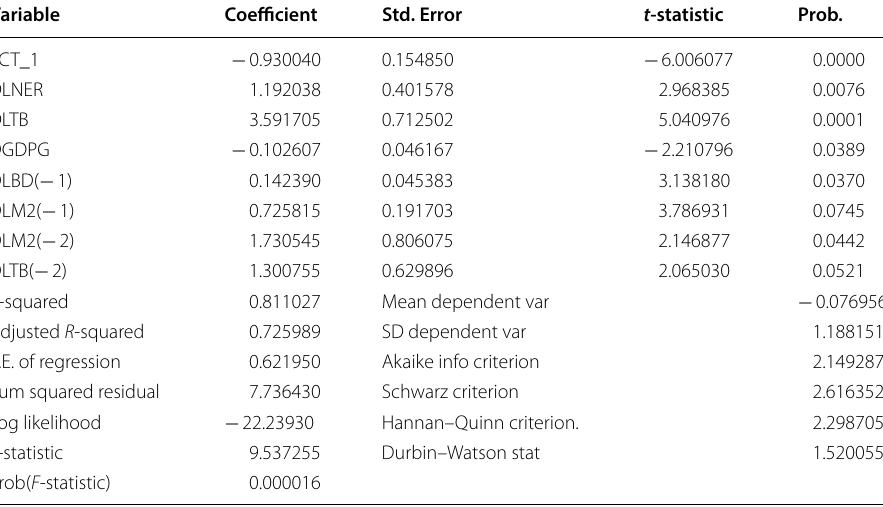
Table 7 Results from the ECM estimation Source : Output from Eviews 7 Variable Coefficient Std.